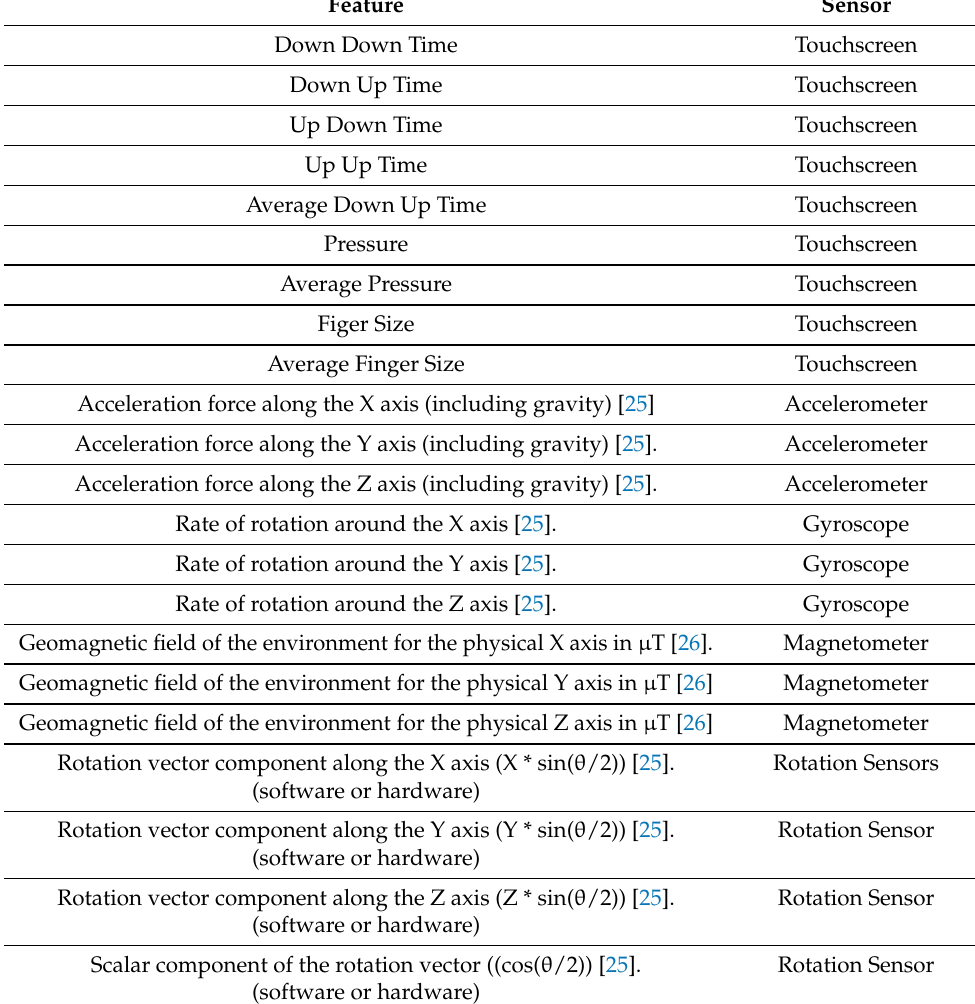
Table 1. Features collected for Moments 1 and